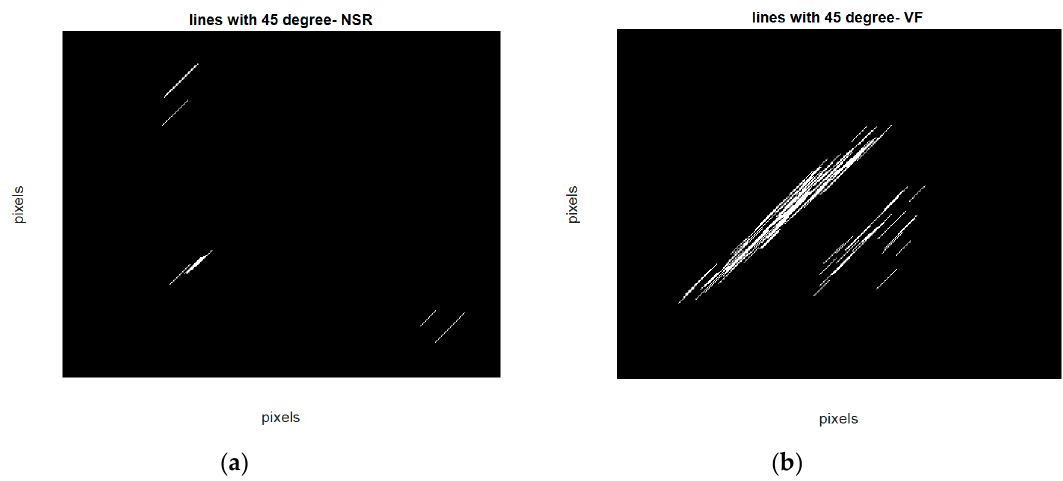
Figure 6. Binary image lines at 45 degrees in the phase plot ( a ) for an NSR segment ( b ) for a VF segment.